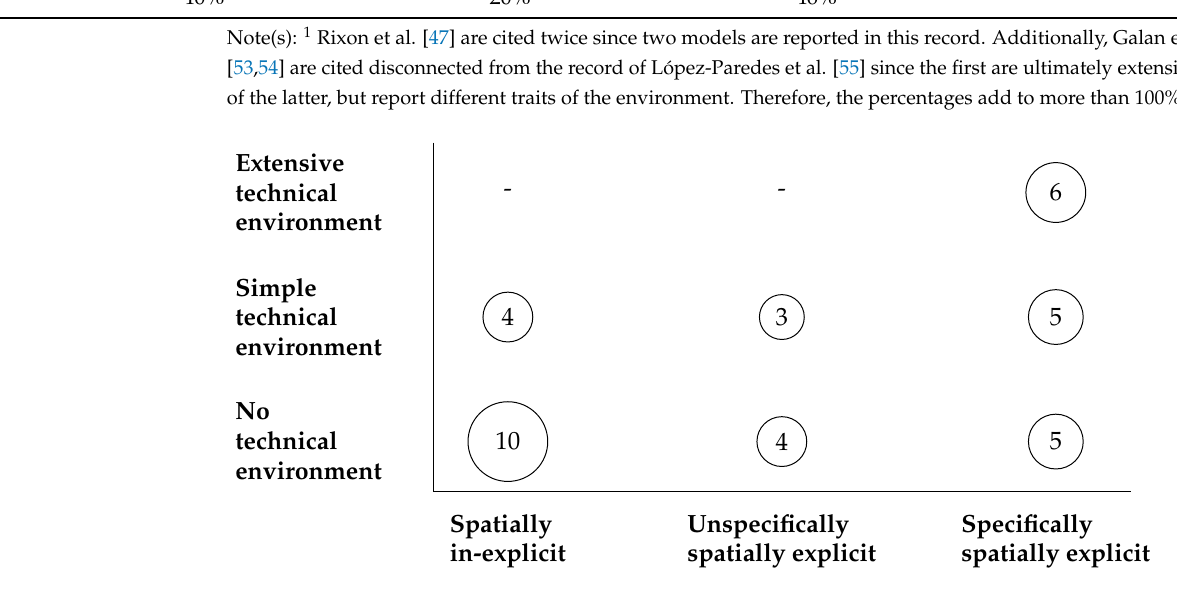
Figure 3. Number of models that include the different types of spatial and technical environment. Some records include multiple models, and some models use different environments in different records, and hence, the numbers in the graphic add up to over 35